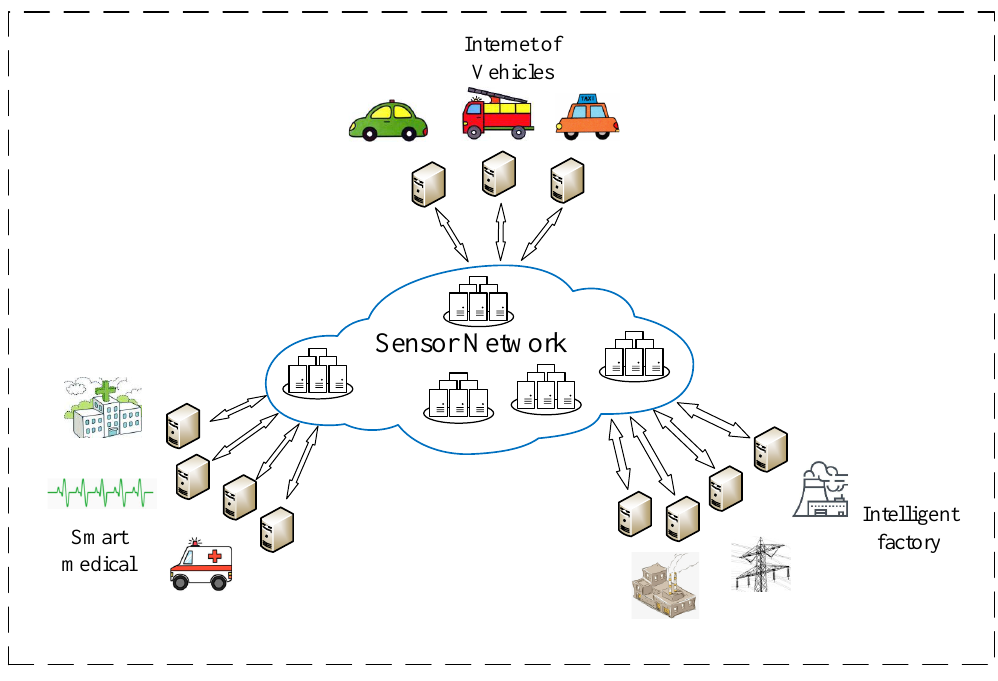
Figure 1. Application scenarios of interdependent sensor networks based on heterogeneous Cyber-Physical System (CPS)